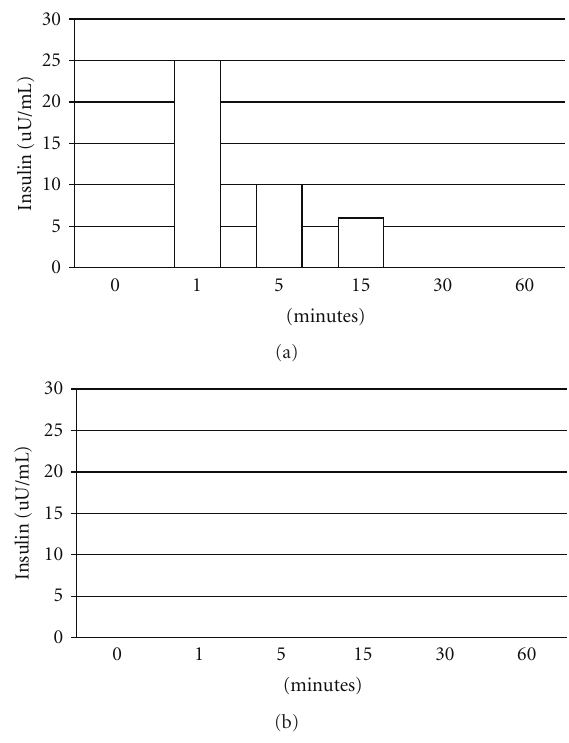
Figure 4: Levels of insulin (uU/mL) measured over 60 min in vitro after addition of glucose to tissue following time 0: (a) from a macaque kidney implanted with porcine islets following trans- plantation of E28 pig pancreatic primordia in mesentery; (b) the contralateral nonimplanted kidney. Reproduced with permission from Organogenesis [8].